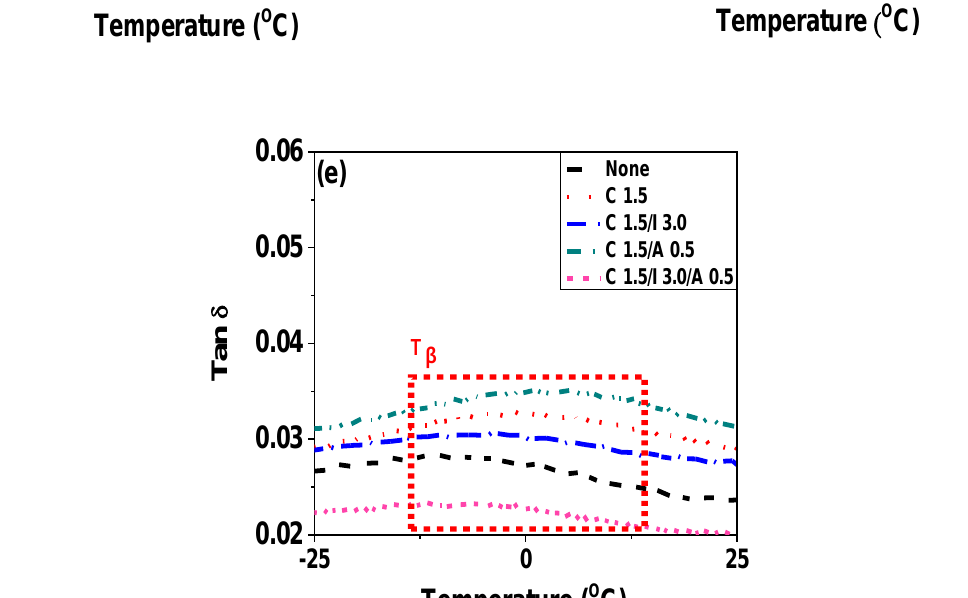
Figure 12. DMA data of neat POM and various nanocomposites (POM/C1.5, POM/C1.5/I3, POM/C1.5/A0.5, and POM/C1.5/I3/A0.5): ( a ) storage modulus; ( b,d ) loss modulus; ( c,e ) tan δ ; ( d ) zoomed in area of Figure 12b; ( e ) zoomed in area of Figure 12c.